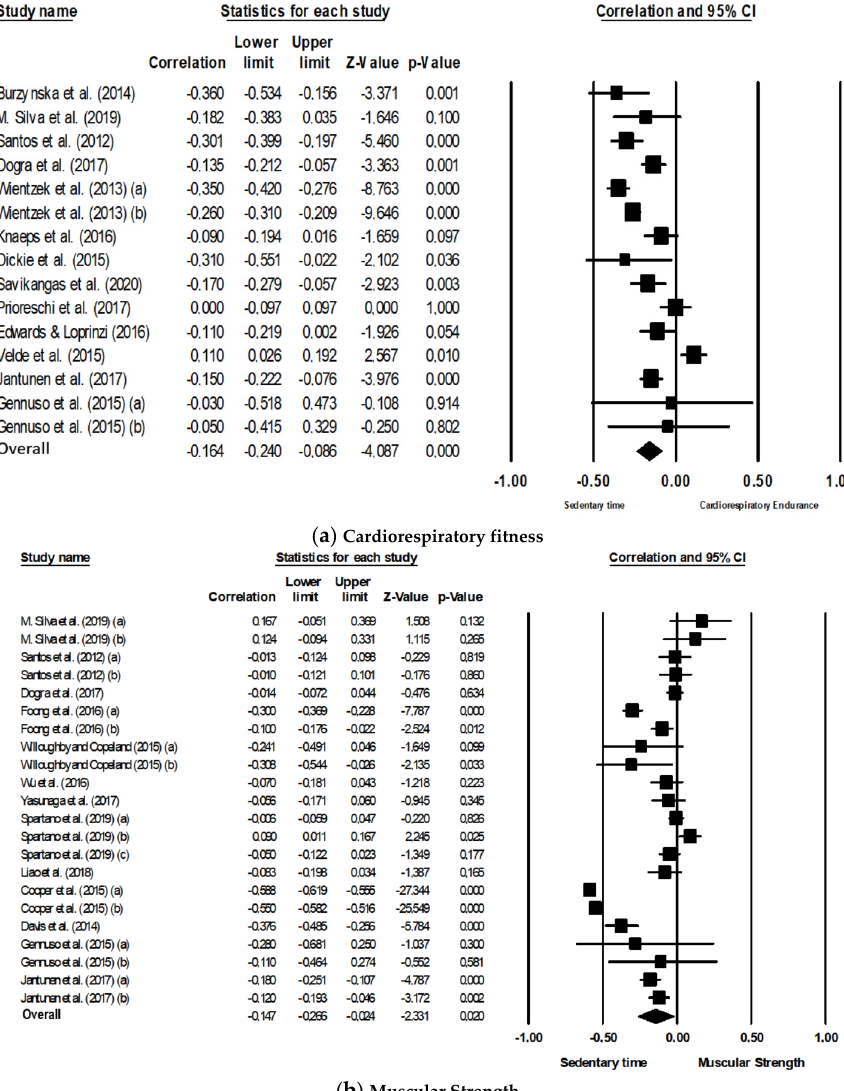
(Figure 2c). The Z-value for testing the null hypothesis was − 0.523 ( p = 0.601), so we can accept